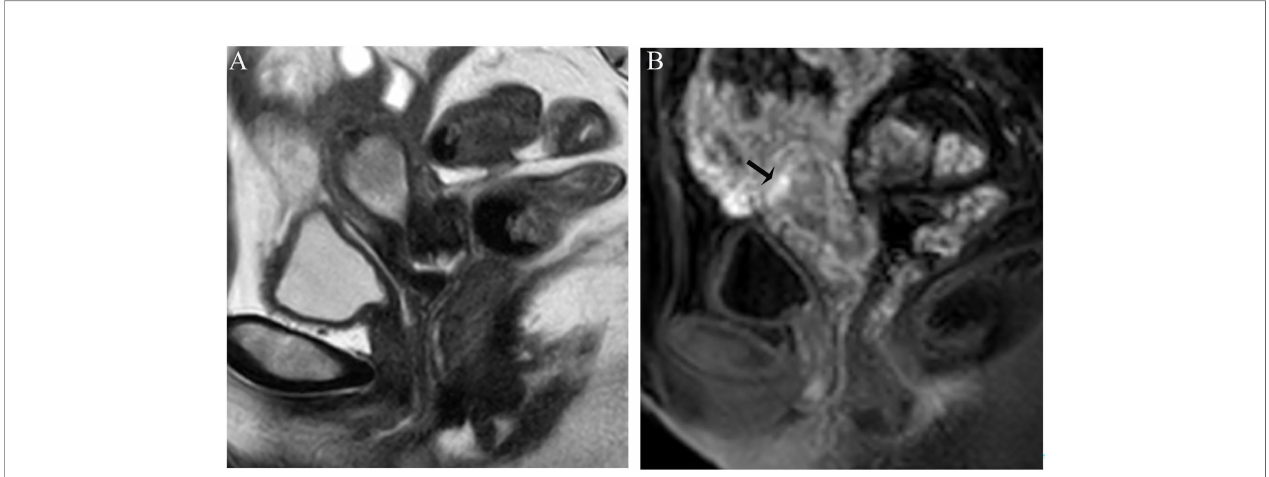
FIGURE 2 | (A) Sagittal-T2WI image, the tumor has moderate signal intensity and is found in the uterine cavity. (B) Early (32.9 s) sagittal-DCE image shows an irregular thin-layered enhancement (ITLPE); an irregular thin-layered enhancement in front of the tumor (black arrow). This case was histologically proven to have endometrioid carcinoma, G2 with super fi cial myometrial invasion.